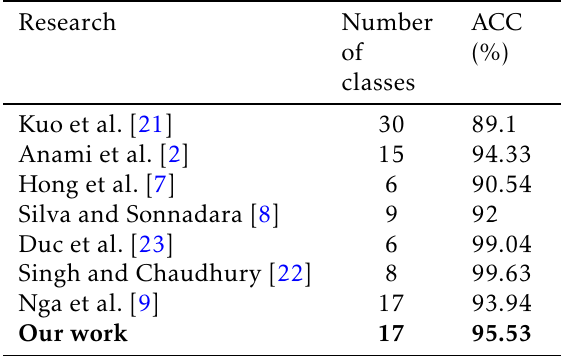
Table 6. Comparison with research on rice varieties classification from the